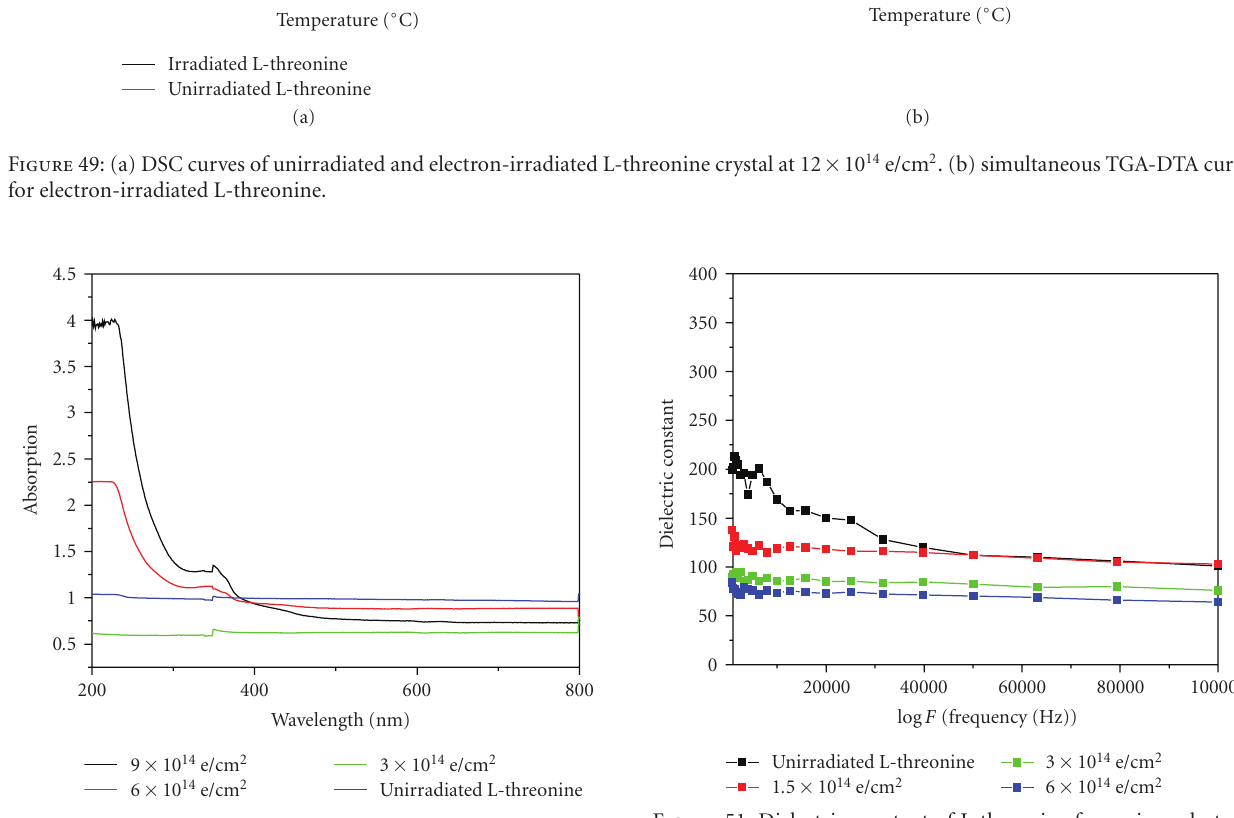
Figure 50: UV-Vis-NIR spectra of pure and irradiated L-threonine. Centre (IUAC) New Delhi, India were allowed to incident